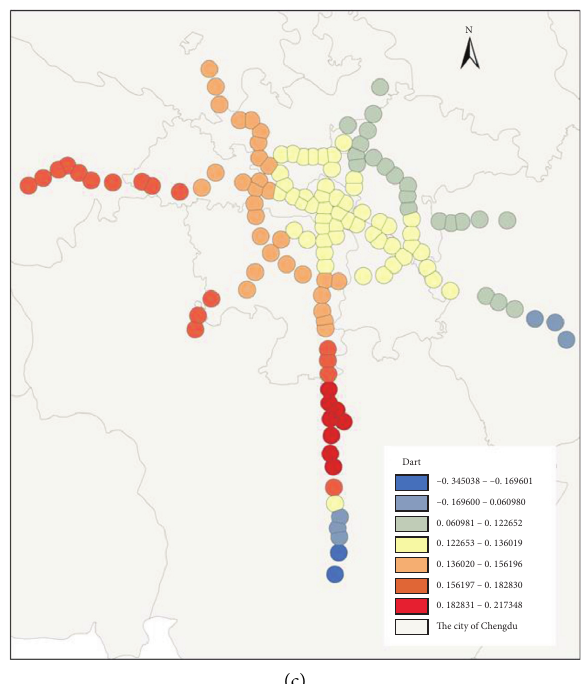
Figure 14: (a–c) Spatial distribution of the coefficients of the three variables: national highway, railway, and dart in the MGWR model,